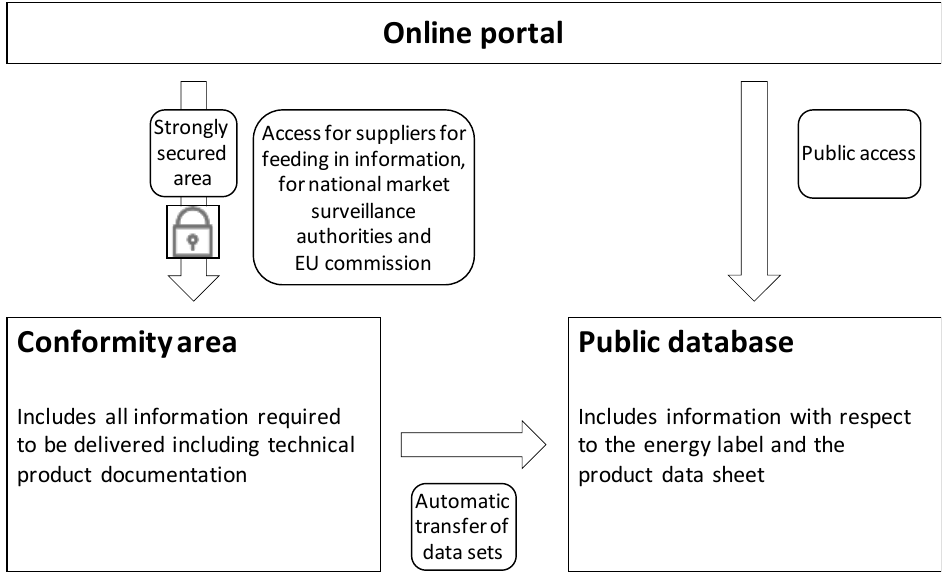
Figure 2. Schematic figure of the EPREL database (based on BMWi 2019 [22]).